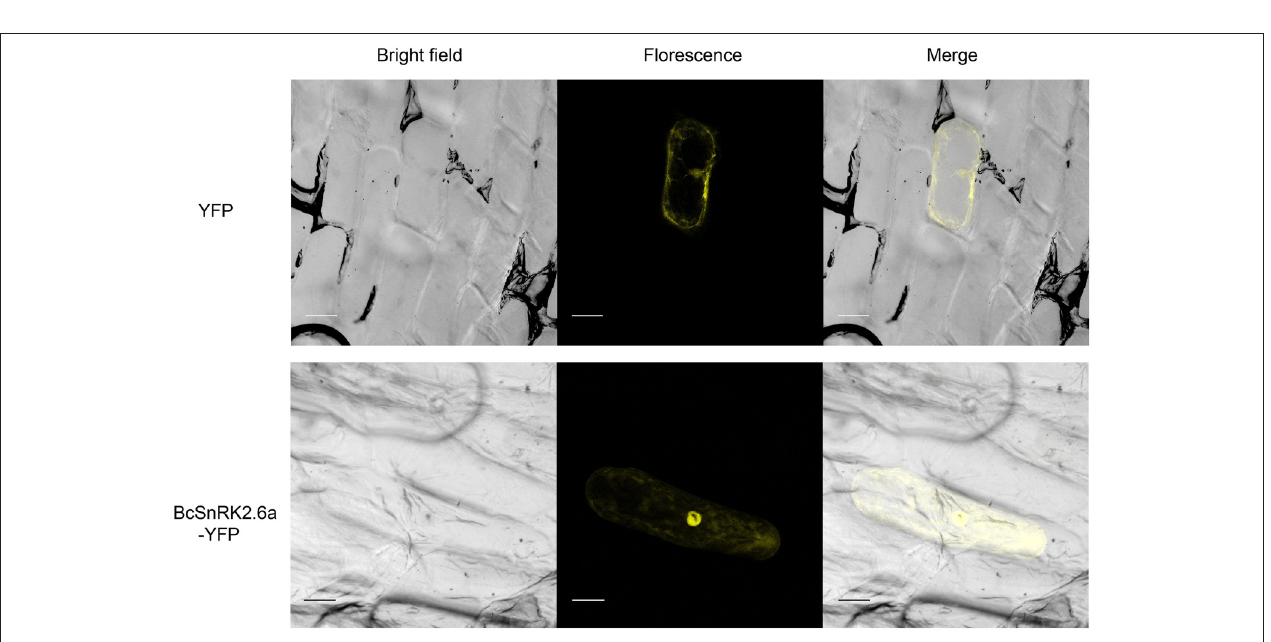
FIGURE 5 | Conserved evolution of SnRK2.6b—3D. (A) Crystal structure of the putative SnRK2 protein based on SnRK2.6b. The six subunits are marked with 1 and 6, respectively. (B) The amino acids were presented as gray balls on the spatial structure. (C) Residues are colored according to their levels of conservation. The score is 1–9 as blue to purple, which represents viable to conserve.